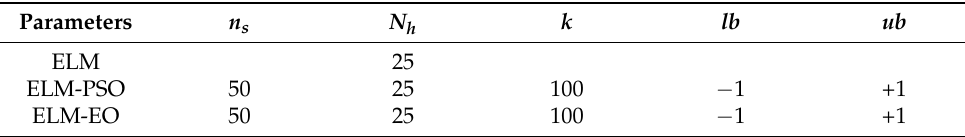
Table 4. Configuration of optimum hybrid ELM